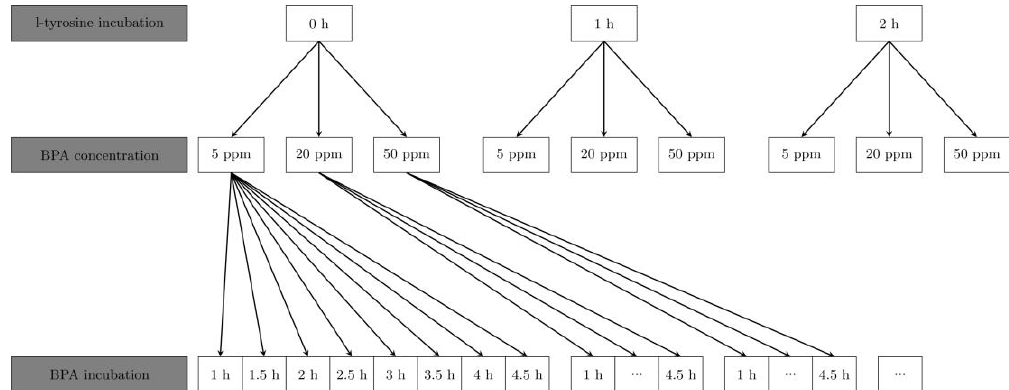
Figure 1. Flowchart of the different groups of L-tyrosine incubation times, used BPA concentrations and BPA incubation times; ppm = parts per